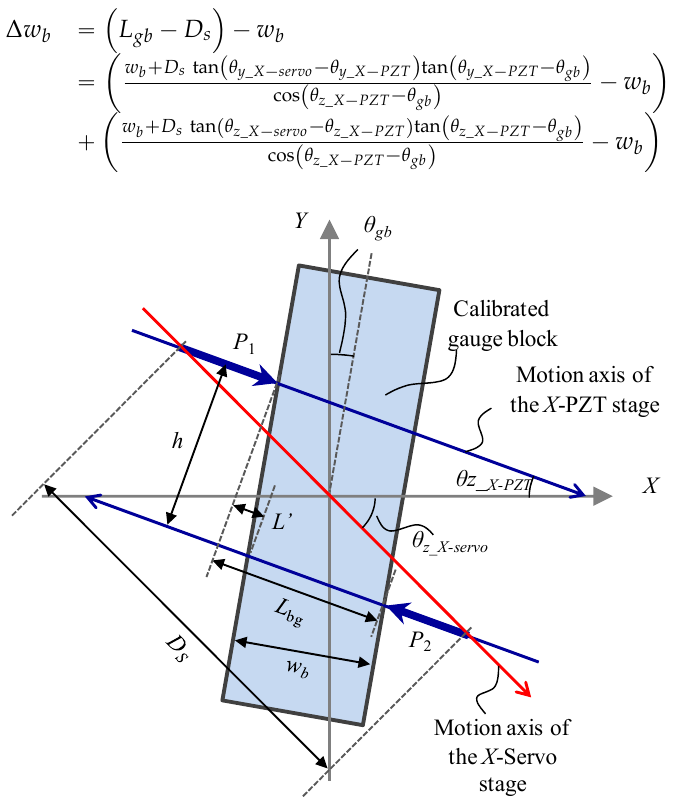
Figure 10. Geometrical model of the alignment error of the probing points during the qualification procedure.